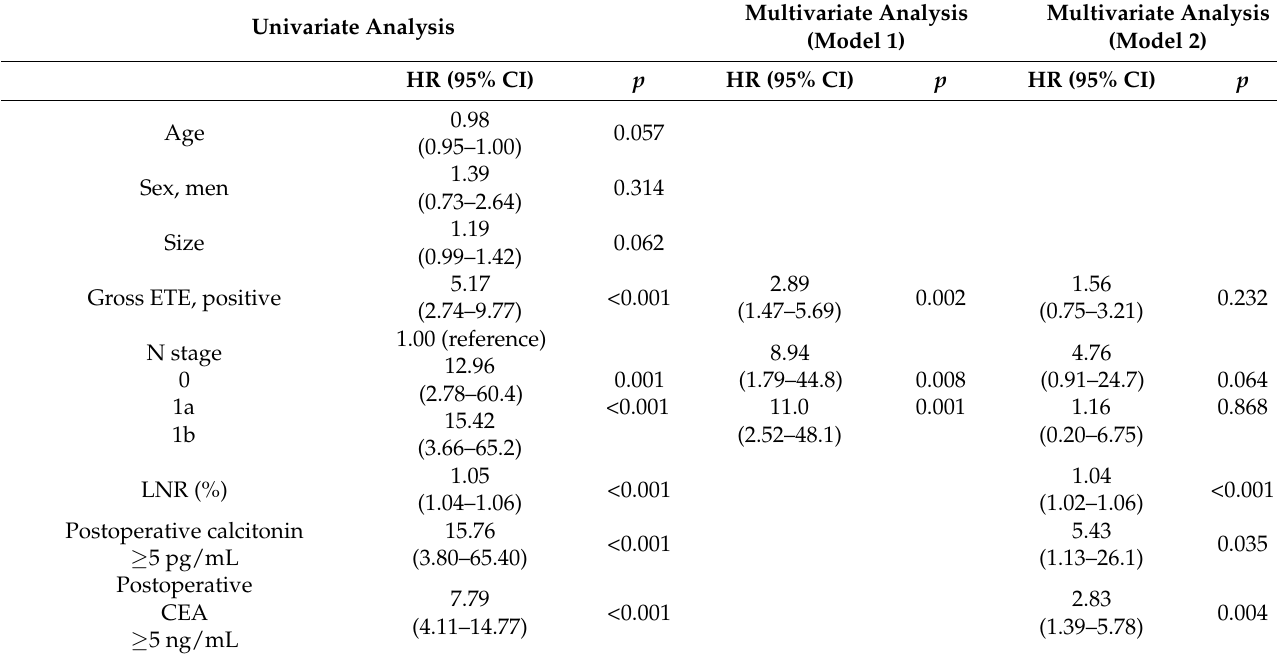
Table 4. Univariate and multivariate Cox regression models for predicting structural recurrence. Univariate Analysis